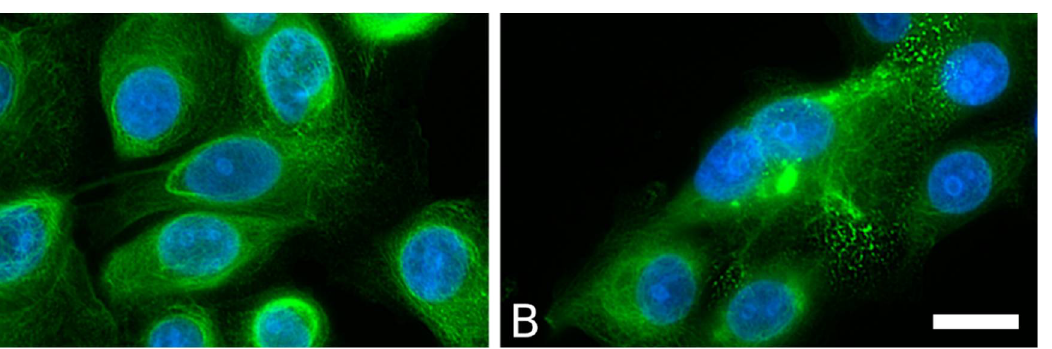
Figure 4. Effect of hypo-osmotic shock on the keratin cytoskeleton. ( A ). Normal immortalized cell line, NEB-1. ( B ). EBS- derived cell line, KEB-7. Both cell lines were subjected to hypo-osmotic shock and then fixed, permeabilized, and stained for K14 intermediate filaments. Clear peripheral aggregates were seen in KEB-7 cells 30 min after hypo-osmotic shock and remained for at least 3 h (seen in the picture). No filament fragmentation or aggregates were observed for NEB-1 cells. Scale bar = 22 µ m. Images are adopted from